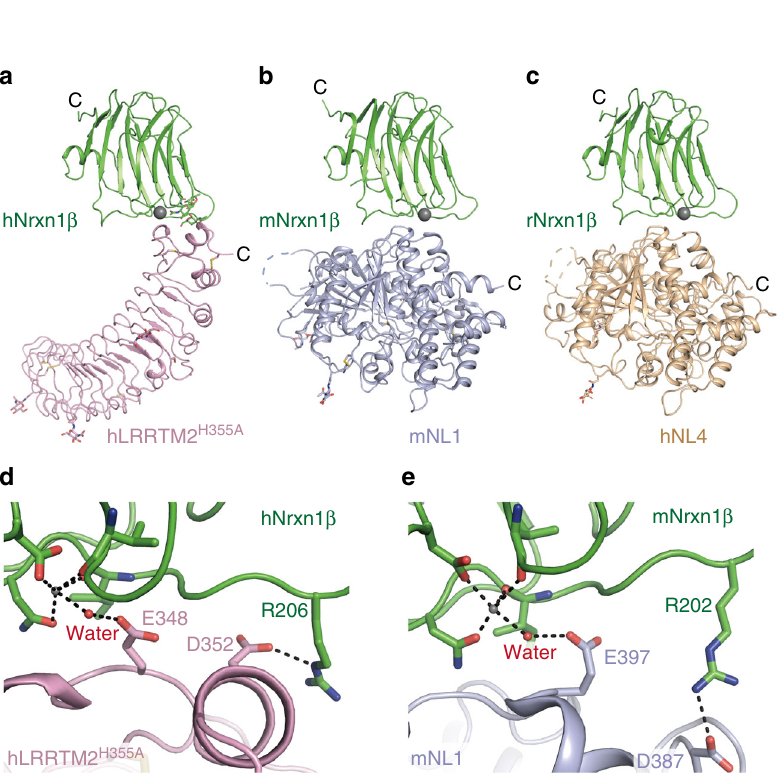
Fig. 3 Structural comparison of Nrxn1 β – LRRTM2 and Nrxn1 β – NL complexes. a Structure of human Nrxn1 β (hNrxn1 β ) – human LRRTM2 H355A (hLRRTM2 H355A ) complex. Nrxn1 β and LRRTM2 are colored in green and pink, respectively. The coordinated Ca 2 + is shown as a gray sphere. b Structure of mouse Nrxn1 β (mNrxn1 β ) – mouse NL1 (mNL1) complex (PDB 3B3Q [http://dx.doi.org/10.2210/pdb3B3Q/pdb]). Nrxn1 β and NL1 are colored in green and light purple, respectively. c Structure of rat Nrxn1 β (rNrxn1 β ) – human NL4 (hNL4) complex (PDB 2WQZ [http://dx.doi.org/10.2210/pdb2WQZ/pdb]). Nrxn1 β and NL4 are colored in green and beige, respectively. d Close-up view of the hNrxn1 β – hLRRTM2 H355A interface. The key residues in this interface are shown as sticks. The coloring scheme is the same as that in a . e Close-up view of the mNrxn1 β – mNL1 interface. The key residues in this interface are shown as sticks. The coloring scheme is the same as that in